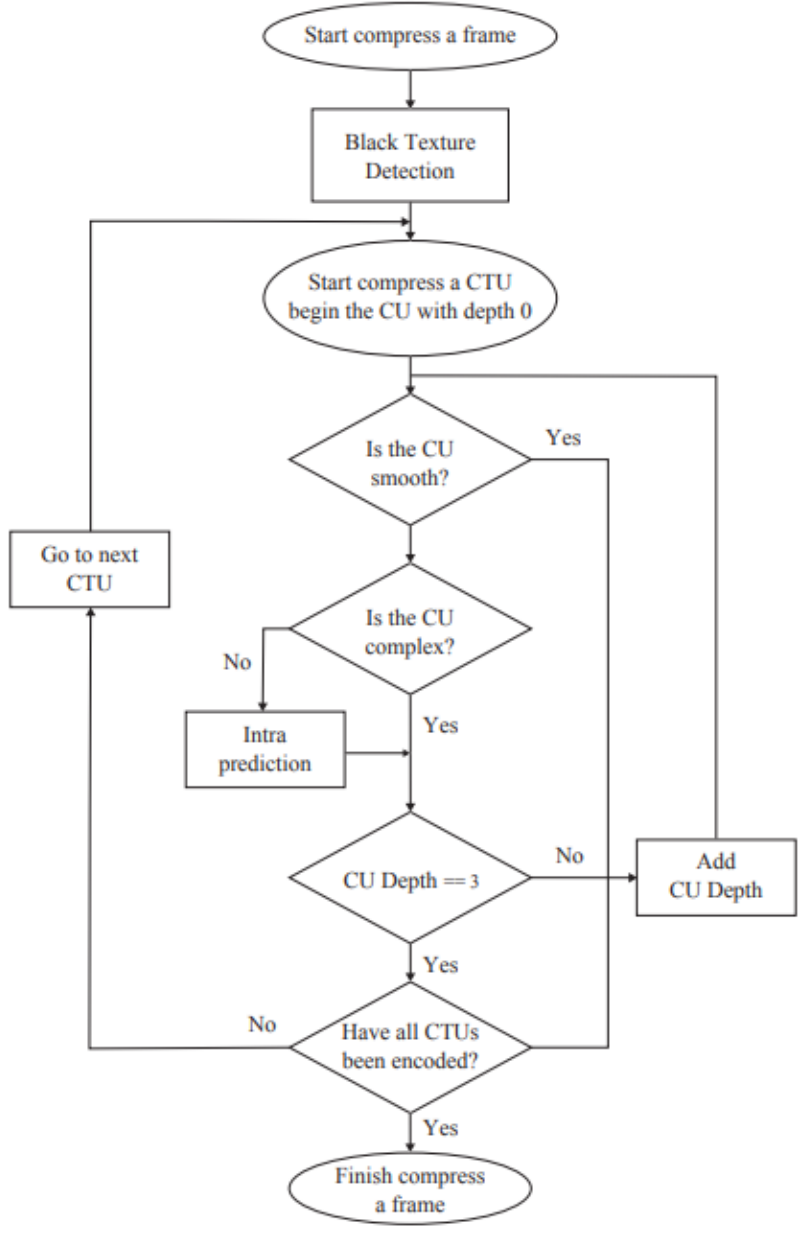
Figure 7. Algorithm for CU